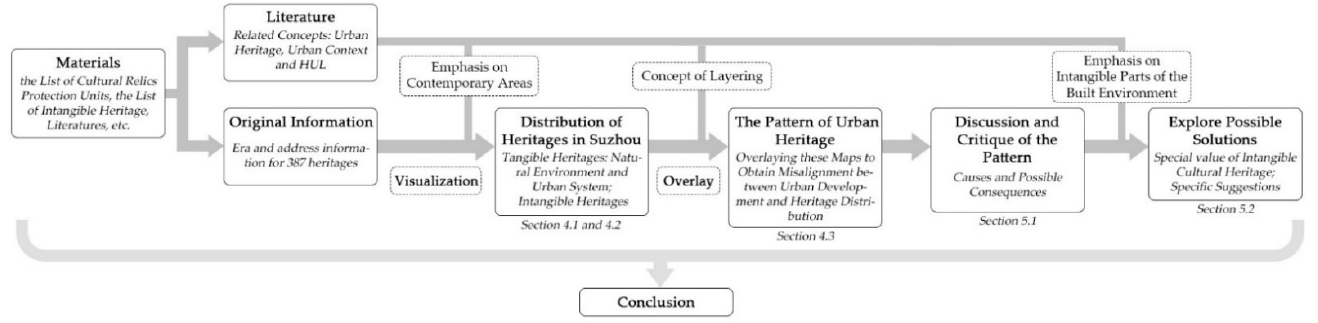
Figure 1. Flow chart of this research.